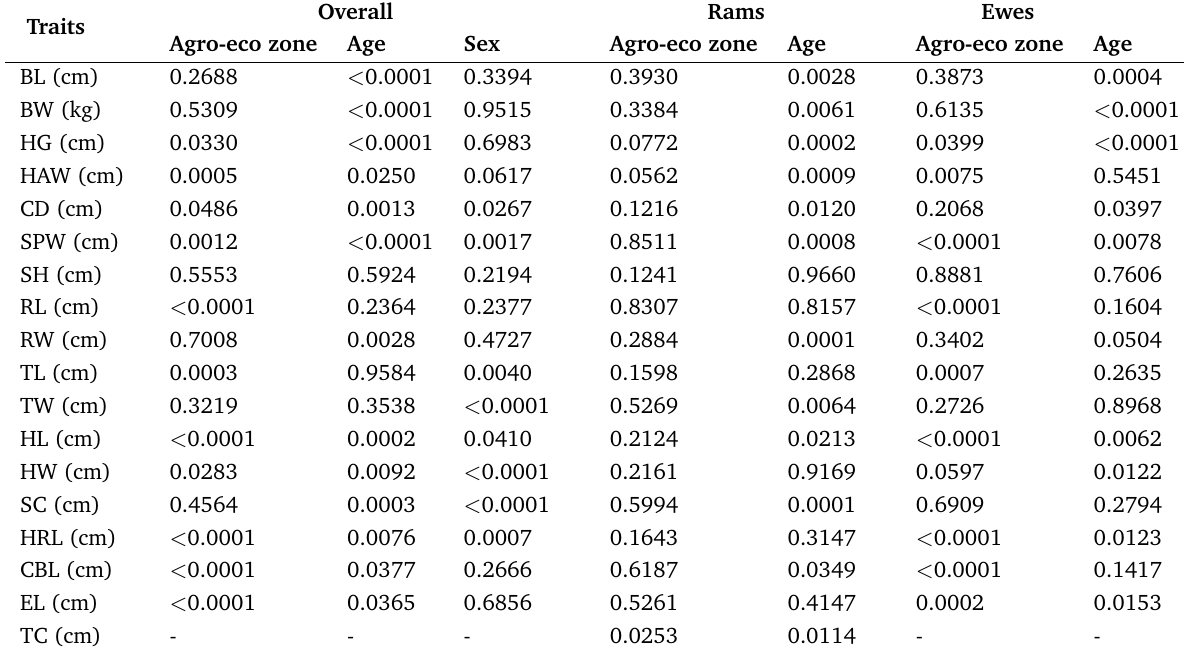
Table 2. Level of significance for the overall analysis and separately for both sexes Traits